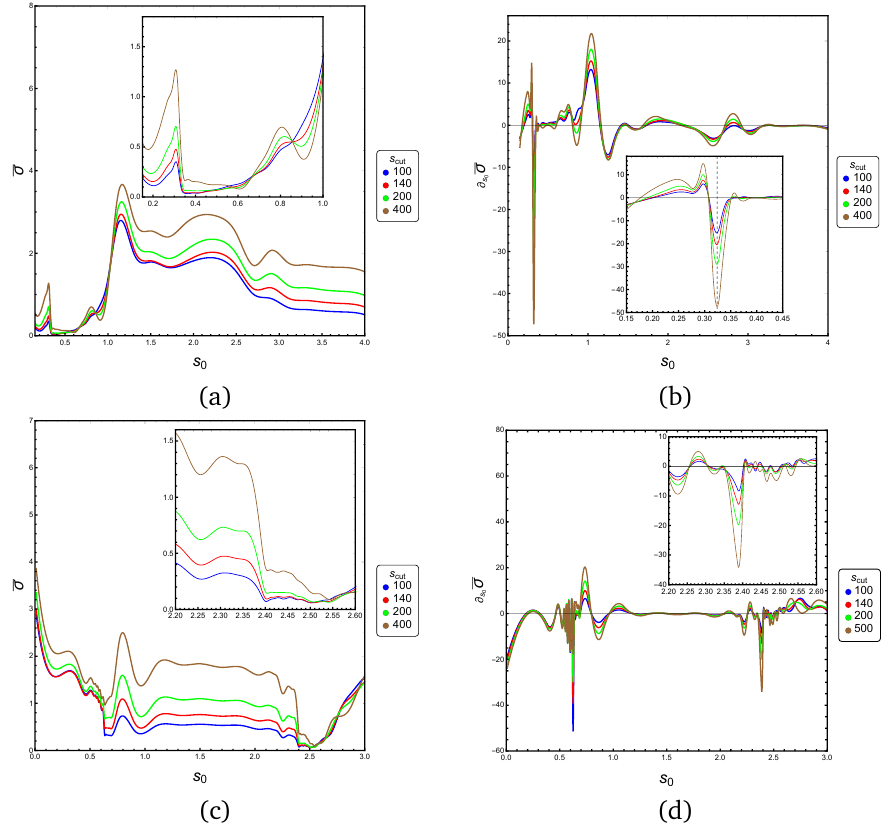
Figure 14: (a) Variation of ¯ σ π 0 π 0 with s 0 on the upper boundary and (b) Variation ¯ σ with s 0 on the upper boundary for different s cut . (c) Variation of ¯ σ with s 0 of ∂ s 0 on the lower boundary and (d) Variation of ∂ s different s cut